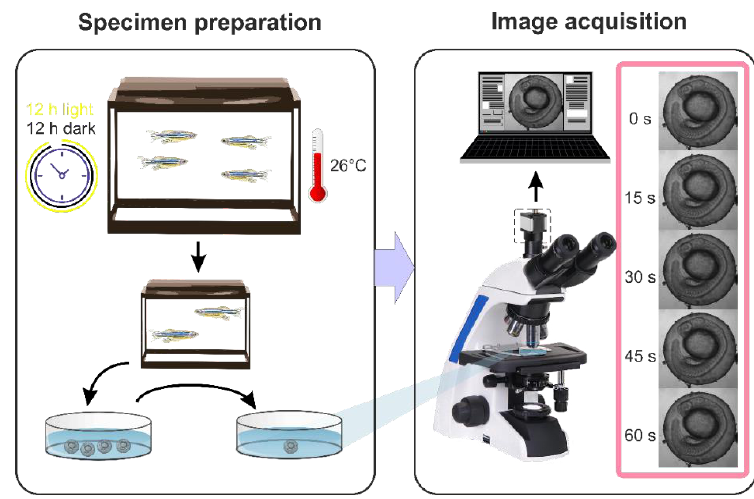
Figure 1. Experimental protocol.